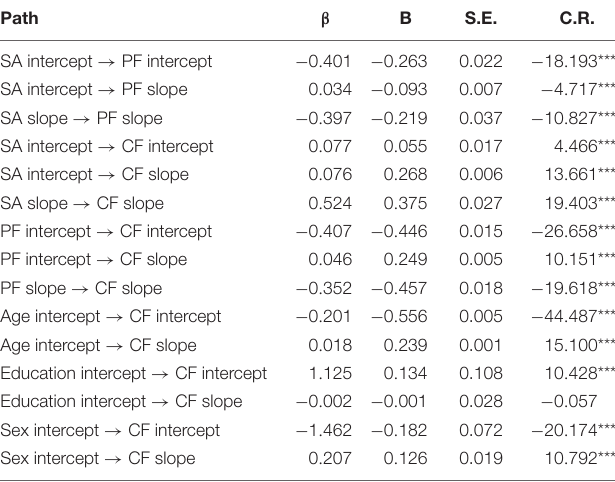
TABLE 4 | Path coefficients of multivariate latent growth